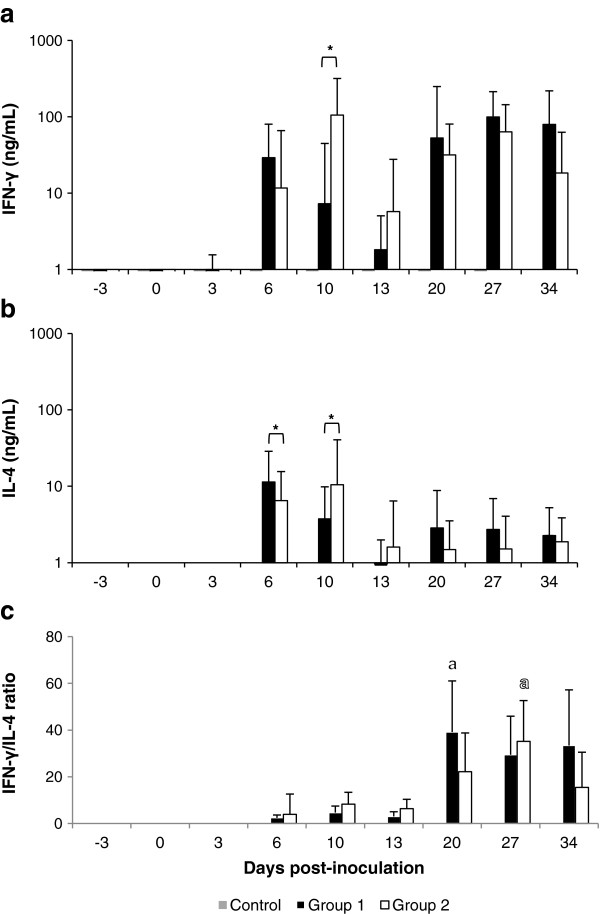
Peripheral IFN-γ and IL-4 responses. Concentrations (ng/mL) of IFN-γ (a) and IL-4 (b) as well as mean IFN-γ/IL-4 ratios (c) segregated by N. caninum antigen-stimulated PMBCs from heifers inoculated with 107 Nc-Spain7 tachyzoites (G1), 107 Nc-Spain8 tachyzoites (G2) or MARC-145 cells as a control group (G3 and G4) (see legend). Results are presented as median + upper quartile value in (a) and (b) or as mean + SE in (c). Filled and empty letters “a” indicate the day on which foetal-death was soon after detected in G1 and G2, respectively. (*) Indicates significant differences (P < 0.05) between infected groups. Data for 49 dpi are not represented.